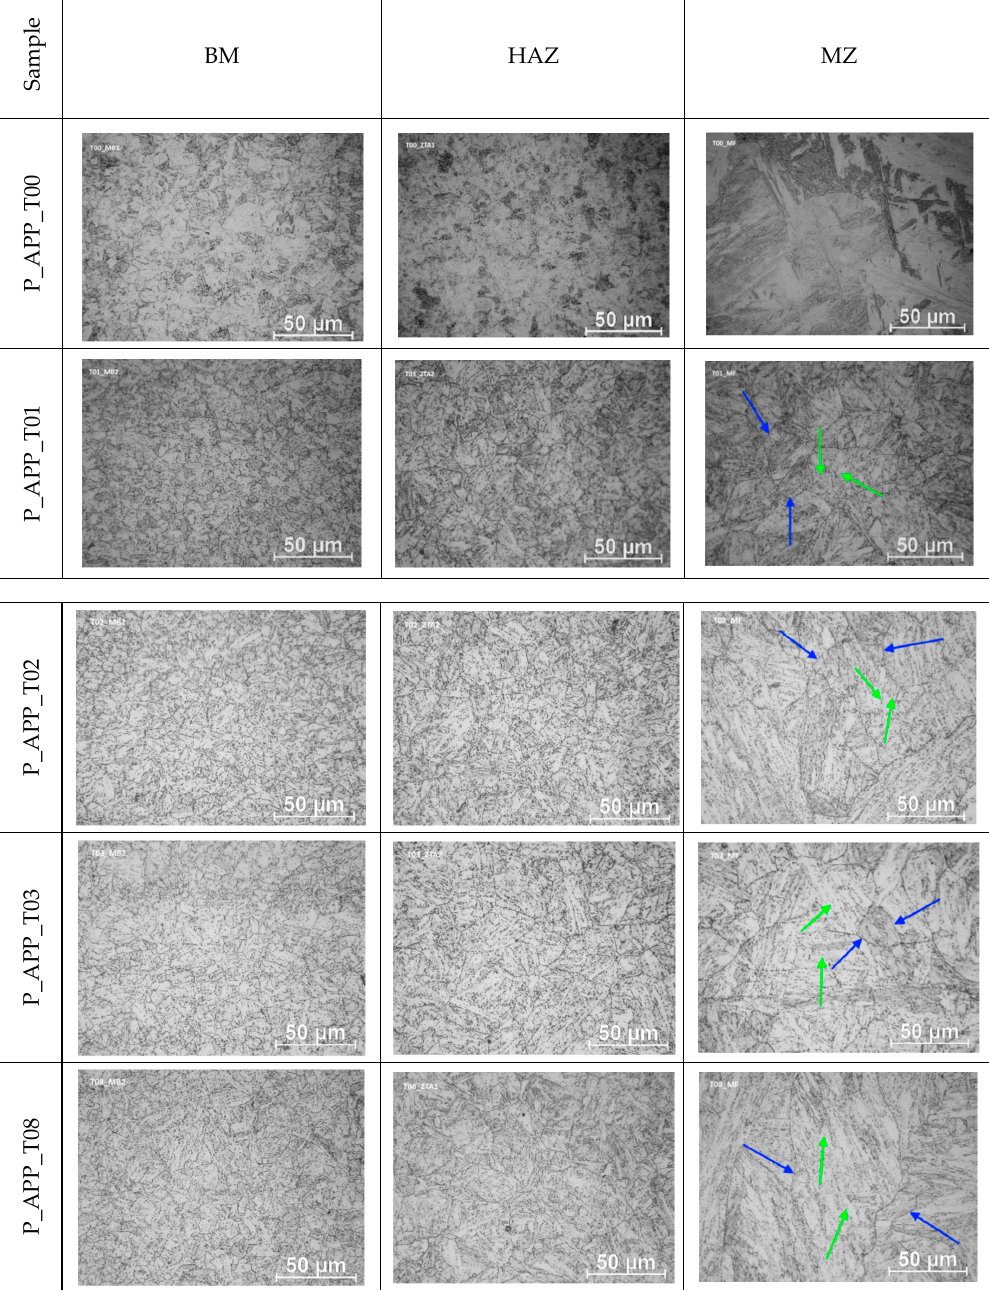
Figure 7. Micrographs of the different cross-section areas for samples subjected to different thermal cycles. Blue arrows highlight grain boundaries and green arrows highlight precipitates.